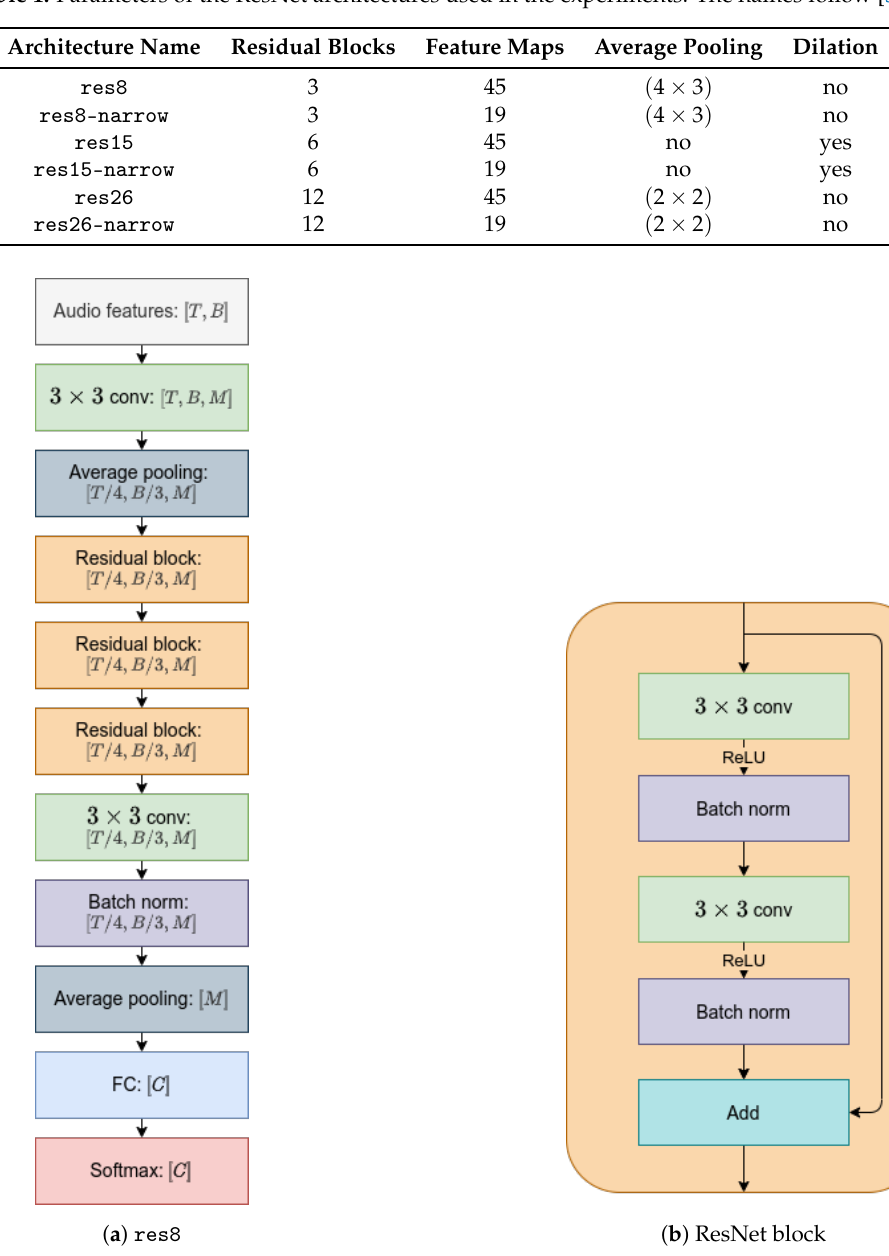
Table 1. Parameters of the ResNet architectures used in the experiments. The names follow [32].